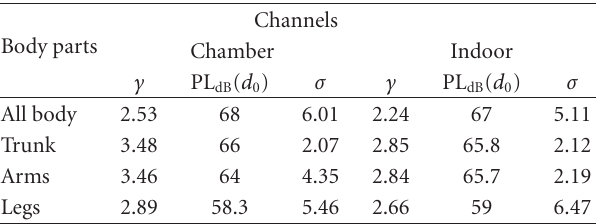
Figure 6: Comparison of average path loss of nine UWB on-body radio channels for standing and walking scenarios measured in the chamber and in indoor. Table 2: Path loss parameters for whole body and di ff erent body parts.